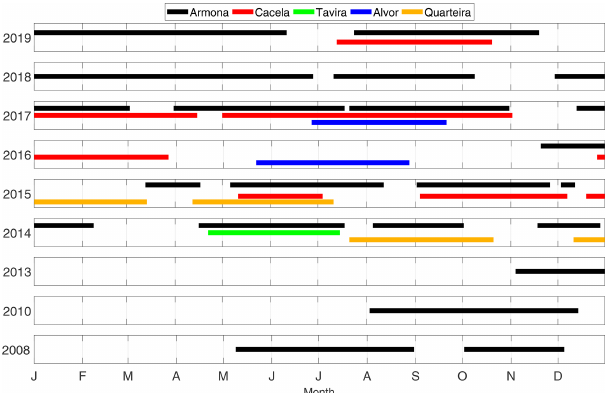
Figure 2. ADCP deployments per month ( x axis) between 2008 and 2019 ( y axis) at Armona (black), Cacela (red), Tavira (green), Alvor (blue) and Quarteira (orange)